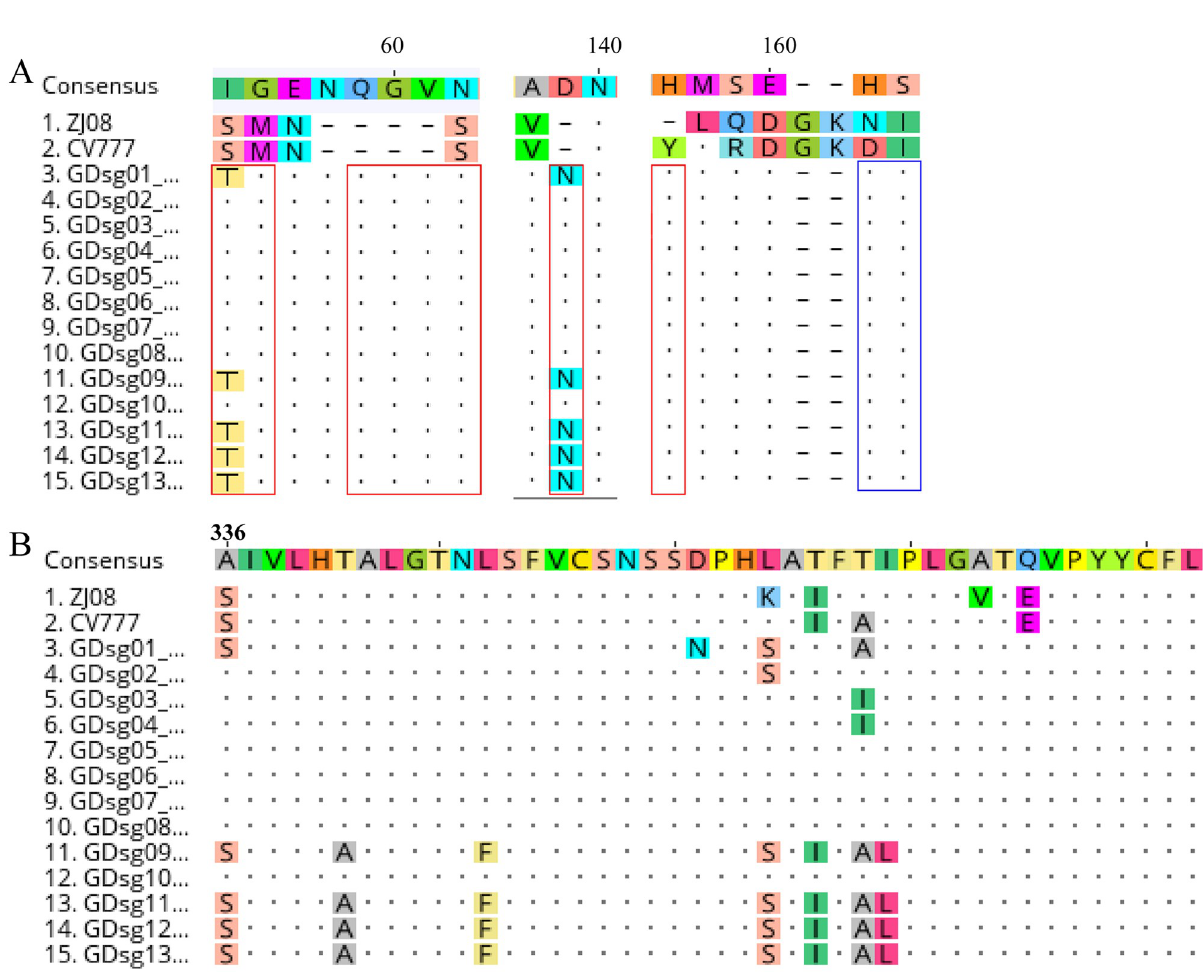
Fig 2. Analysis of animo acid mutations in the S protein of 13 PEDV strains. MUSCLE was used to align the sequences, and Geneious software (Version 11.0.9) was used to visualize them. (A) The common insertions (red box) and deletions (blue box) of amino acid (aa) mutations compared with the reference strains ZJ08 and CV777. (B). The regions in the S1 protein with a relative high polymorphism of mutations. (C) The predicted N- linked glycosylation sites of reference strain (CV777 and ZJ08), and 13 PEDV strains collected in this study. MUSCLE and the Geneious software were used to align the sequences (Version 11.0.9). The purple arrow represents the predicted N-linked glycosylation site based on the consensus N-X-S/T (X can be any amino acid except proline) glycosylation motif.